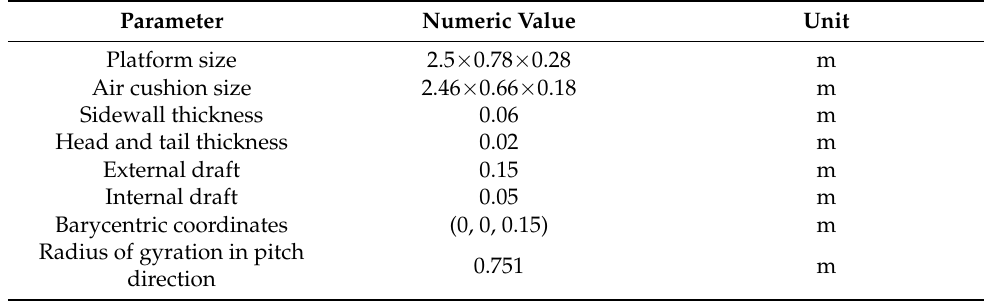
Figure 2. Dimensional parameters of the ACAP [23]. ( a ) 3D model, ( b ) Longitudinal section. Table 1. Principal parameters of the ACAP.